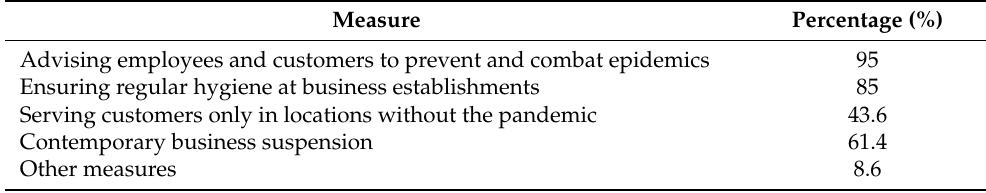
Table 2. Measures to limit the spread of diseases in the tourism businesses’ environments (n = 280). Measure Percentage (%) Advising employees and customers to prevent and combat epidemics 95 Ensuring regular hygiene at business establishments 85 Serving customers only in locations without the pandemic 43.6 Contemporary business suspension 61.4 Other measures 8.6 Source: Data from Huynh et al. (2021).